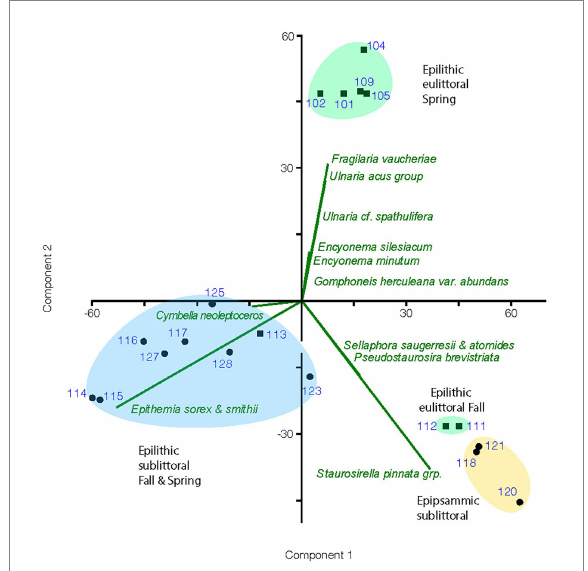
FIGURE 4 Biplot of principal component analysis for enumerated diatom samples showing groupings by habitat and season of samples and a vector overlay of the diatom species most responsible for the variation in assemblage composition between groupings. Sample numbers are the UNRMNH catalog # found in Table 1. Eulittoral samples are marked with a square symbol and sublittoral samples with a circle.